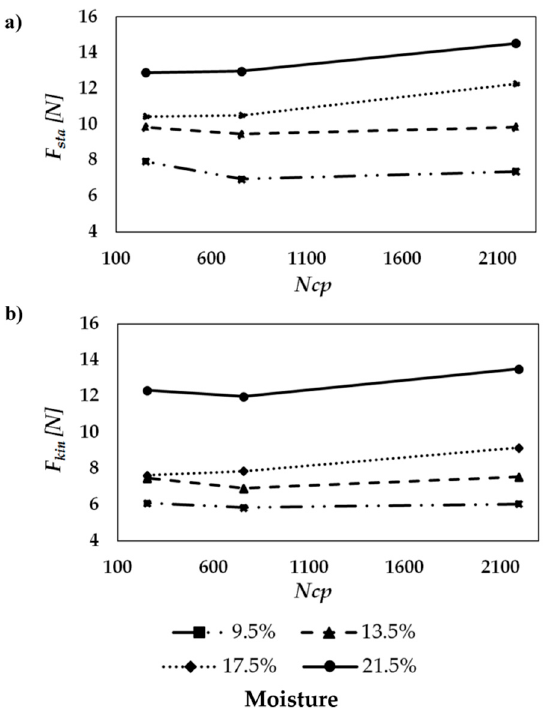
Figure 8. A chart showing the relationship of force of friction to the number of contact points for wheat: ( a ) static friction, ( b ) kinetic friction.